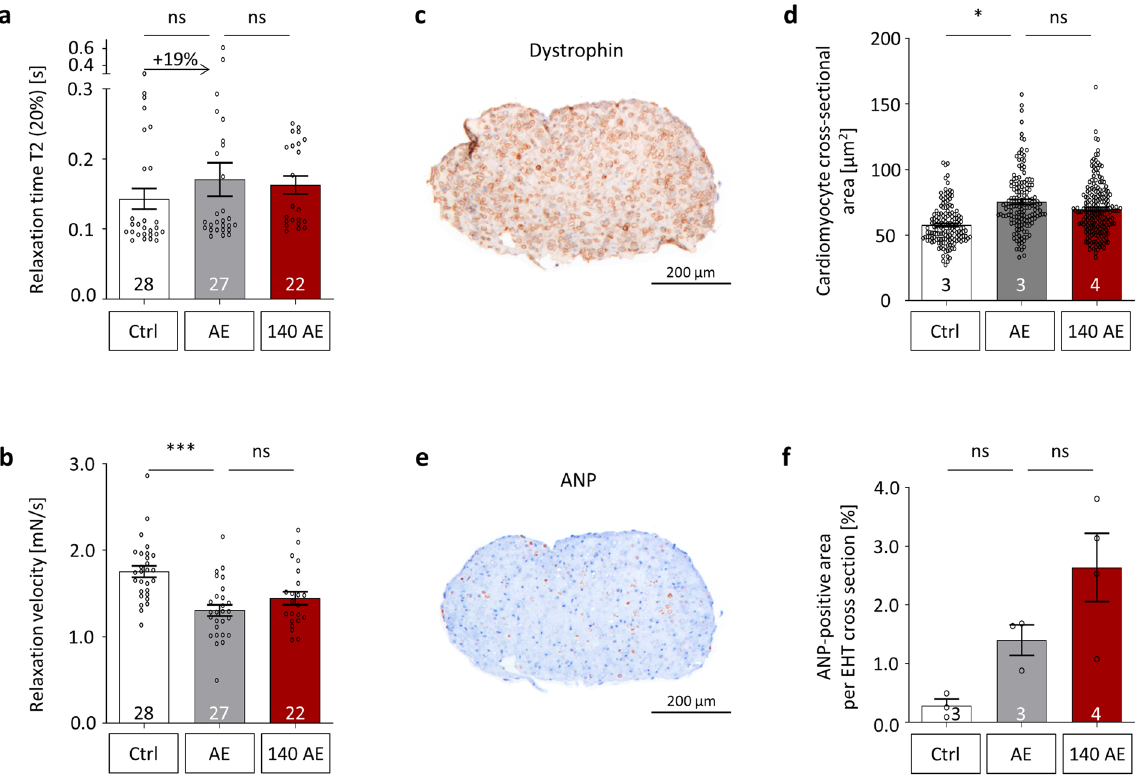
Figure 5. Further characterization of miR-140-3p inhibition with anti-miR-140-3p-S4 in AE-EHTs. Contractility analysis of ( a ) Relaxation time and ( b ) Relaxation velocity of Ctrl-EHTs, AE-EHTs and AE-EHTs pretreated with LNA-anti-miR-140-3p-S4 (140 AE) at the end of the experiments, n = 22–28 EHTs per group. Representative EHT cross sections stained for ( c ) Dystrophin and ( e ) ANP from which ( d ) Cardiomyocyte area and ( f ) ANP-positive area were quantified respectively, n = 3–4 EHTs per group; same groups as in ( a , b ). Bars show mean ± SEM, one-way ANOVA and Dunnett’s post-test for multiple comparisons against AE, * p < 0.05, *** p <